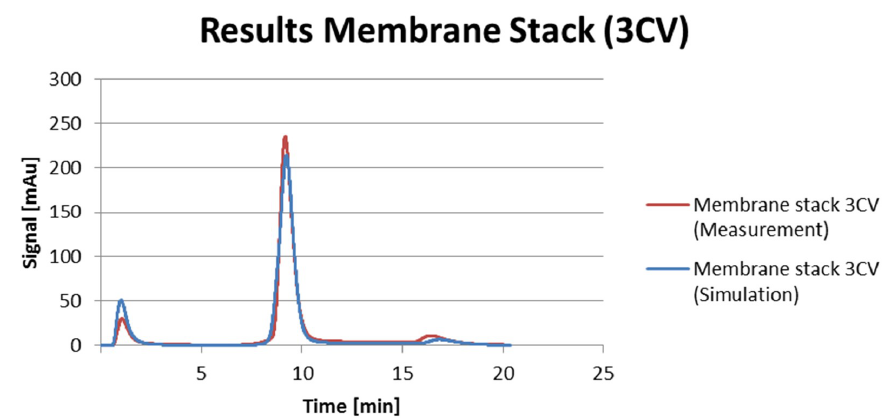
Figure 13. Simulation and experimental results for a membrane stack in a glass column.